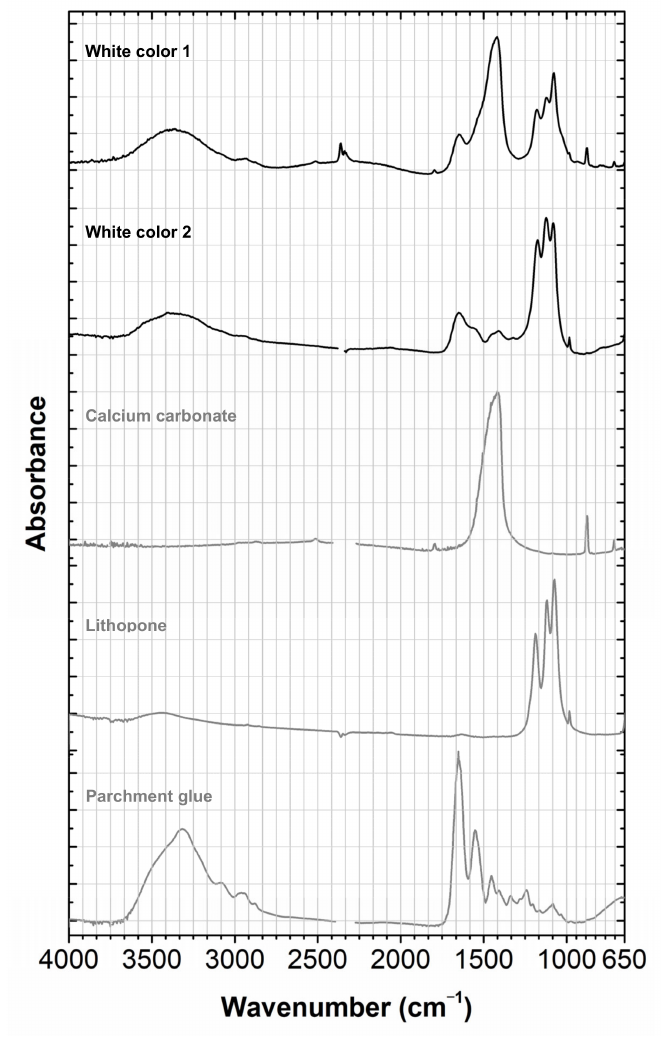
Figure 5. Infrared spectrum of the white color compared with selected references. The white color is a complex formulation, in which the white pigment was identified as lithopone by microRaman in a proteinaceous media, having calcium carbonate as a filler. For more details on white 1 and 2, see Appendix